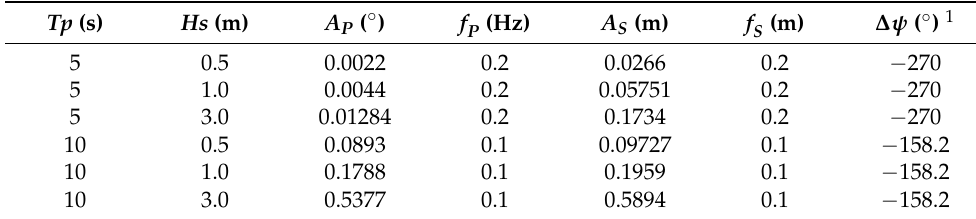
Table 10. Motion states at given sea